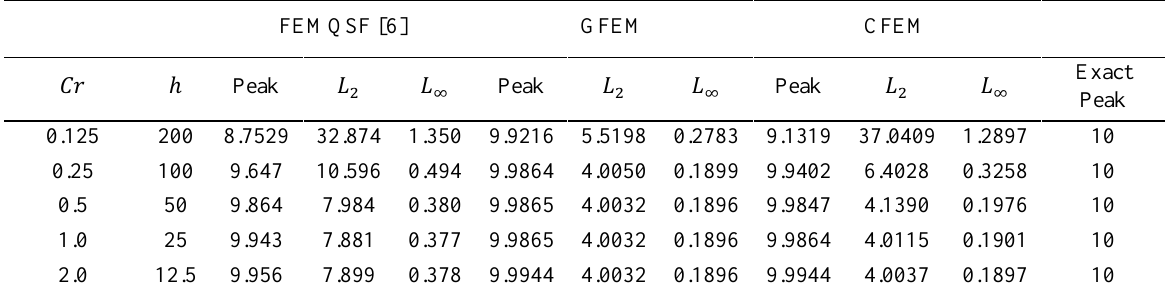
Table 2. Comparison of the error norms produced with various values of the Courant number and (cid:18)(cid:19) (cid:2) ∞ in Problem 1. FEMQSF [6] GFEM